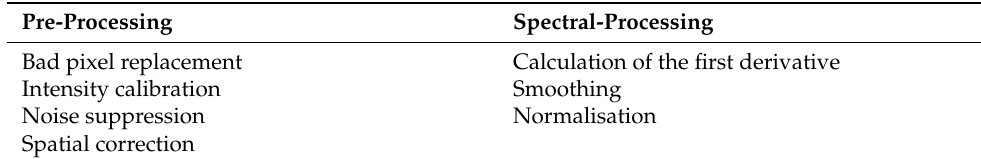
Table 2. List of pre-processing and